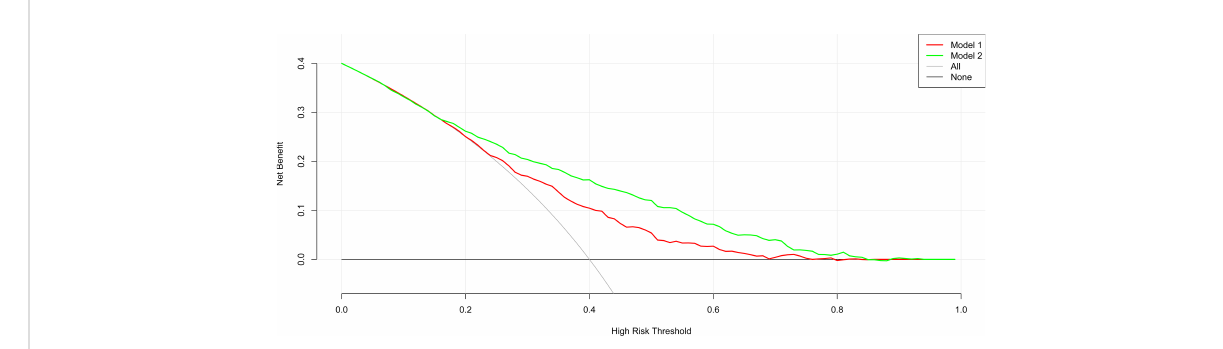
FIGURE 5 Decision curve analysis for the nomogram model in the development and internal and external validation